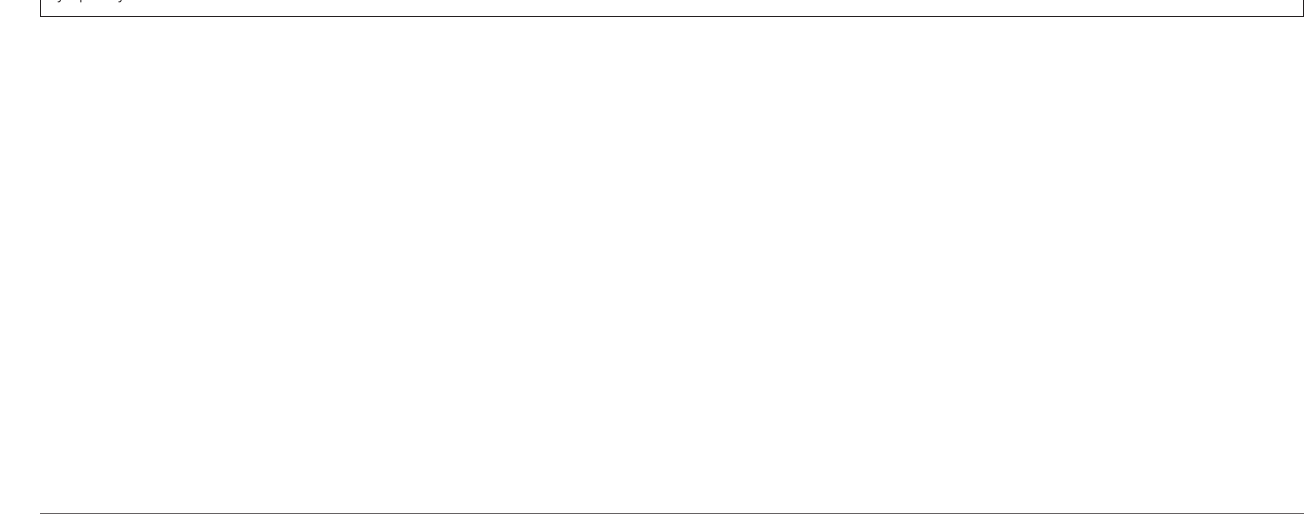
Frontiers in Immunology | www.frontiersin.org